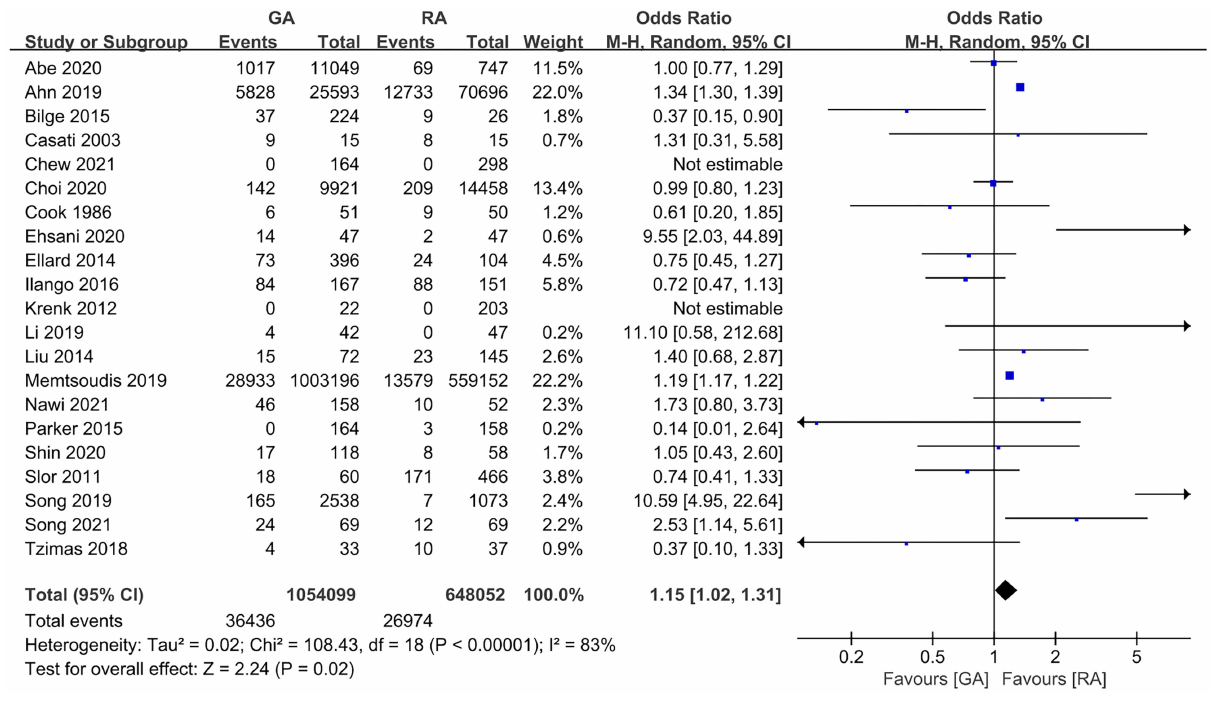
FIGURE 2 | The pooled results of POD incidence after surgery between the patients with GA and RA.